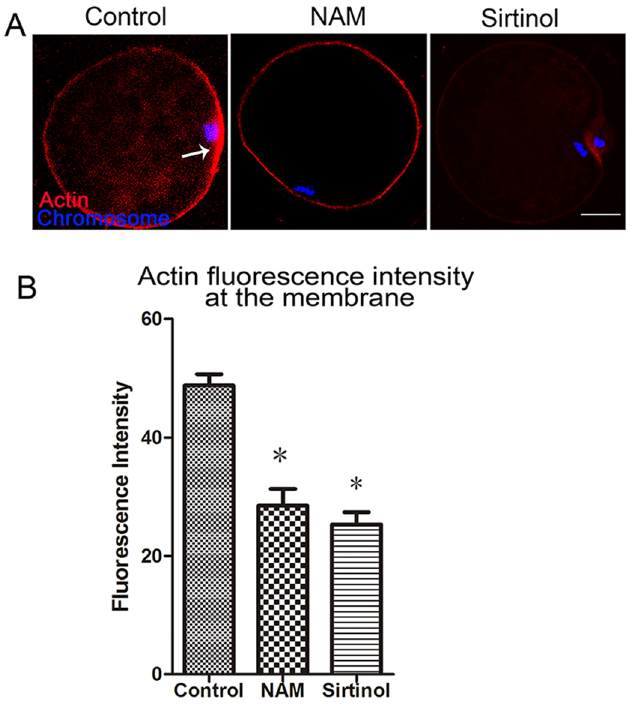
Fig 2. NAM and Sirtinol treatment disrupts actin cap formation. (A) Actin signals in the oocytes were examined by immunofluorescence staining. Oocytes treated with NAM and Sirtinol exhibited profoundly decreased actin fluorescence intensity. Bar = 20 μ m (B) Actin fluorescence intensity at the membrane in porcine oocytes. The signal intensity of ROI of actin was the entire area of the oocyte membrane. Compared to control oocytes, actin fluorescence intensity was significantly decreased in inhibitor-treated oocytes. * significant, p < 0.05.